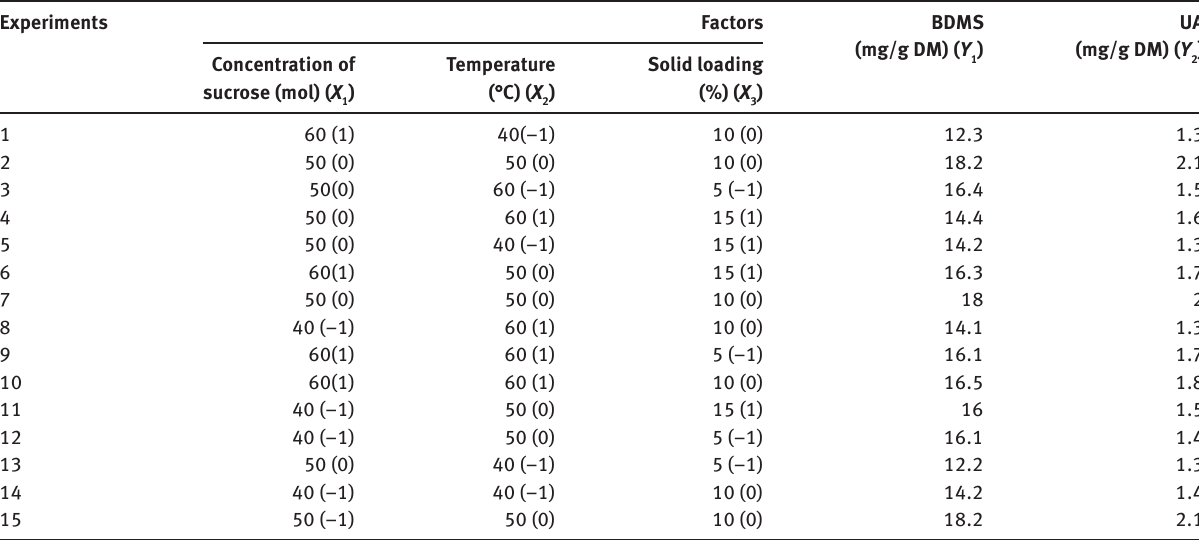
Values in parentheses are coded form of variables. DM, Dry